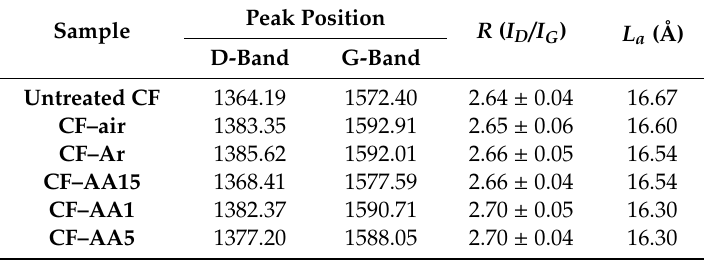
Figure 6. Raman spectra and their cumulative fit peaks for CFs before and after different plasma treatments: ( a ) untreated CF, ( b ) CF–air, ( c ) CF–Ar, ( d ) CF–AA15, ( e ) CF–AA1, and ( f ) CF–AA5. Table 1. Raman analysis: R and surface crystalline size ( L a ) of untreated and treated carbon fibers.